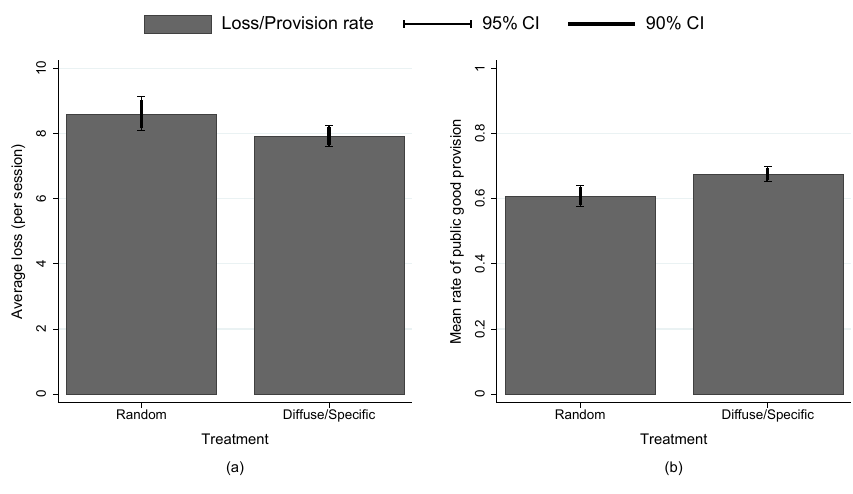
Figure 4: Average loss and mean rate of public good provision by